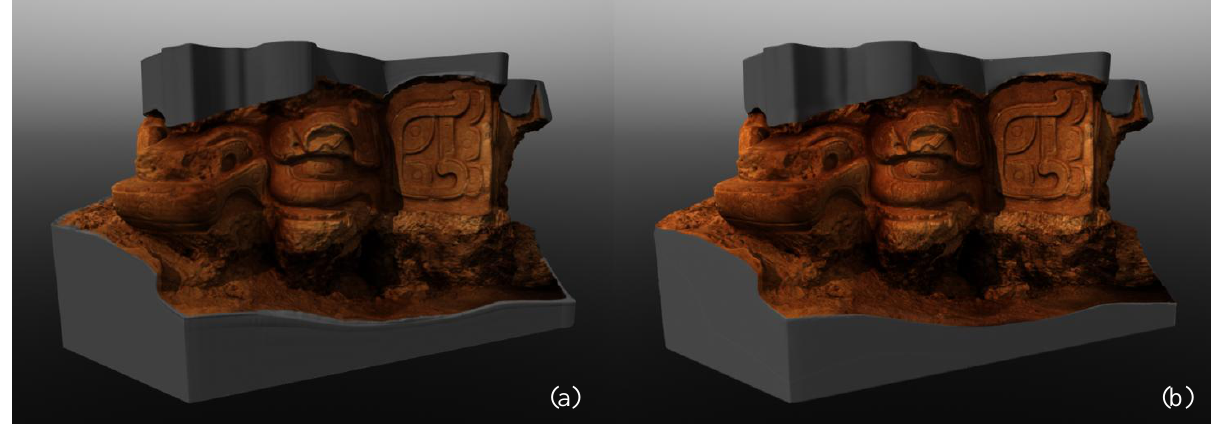
Figure 8. Comparison between optimized models. (a) Subdivision surface from quad-dominant mesh with displacement map and diffuse color map. (b) Triangular isotropic mesh with normal map and diffuse color